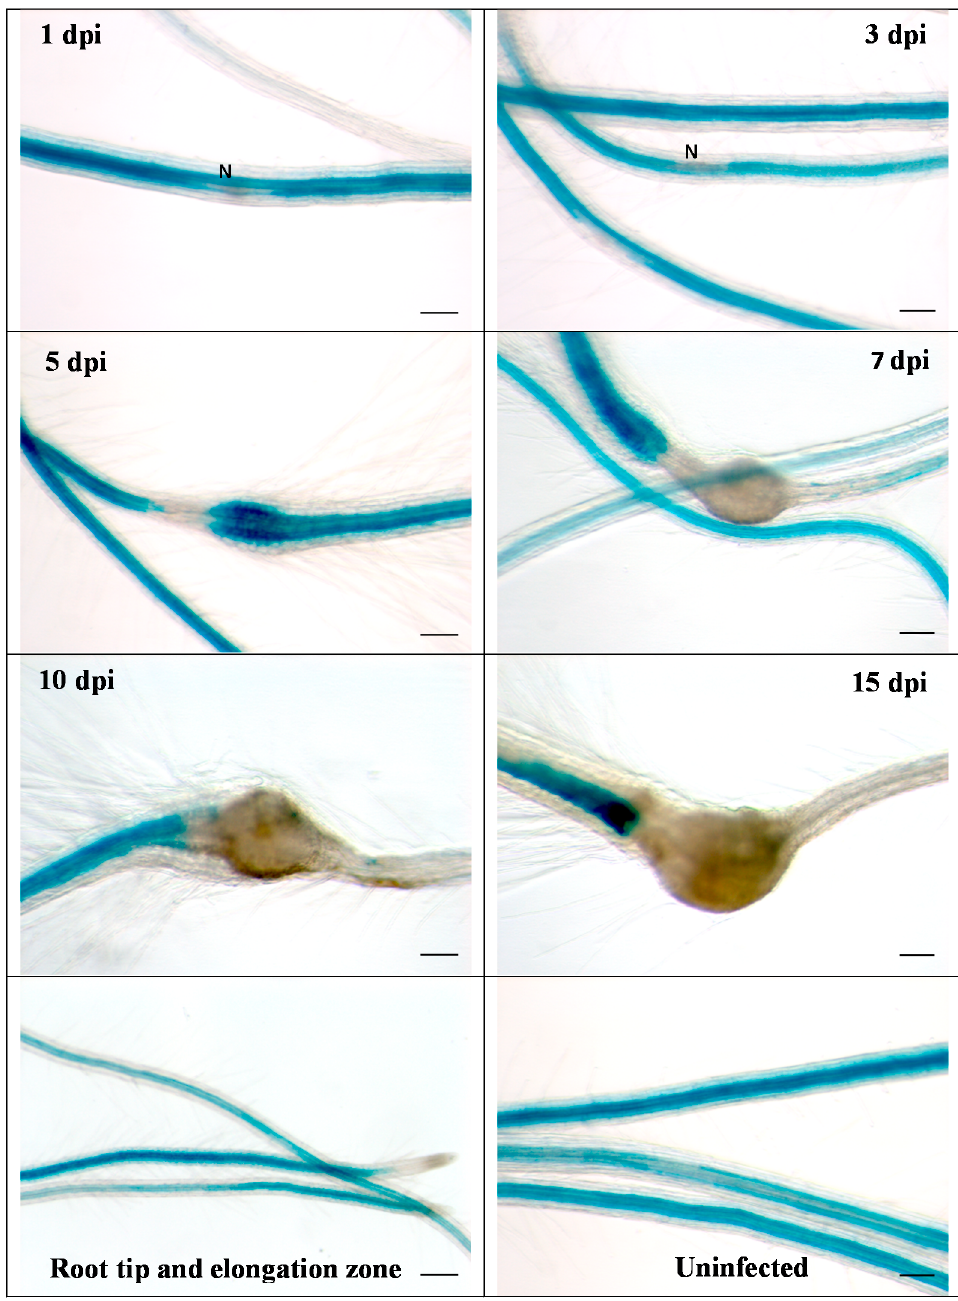
Figure 3. GUS expression in RbohB::GUS transgenic line infected with M. incognita . Shown are infection sites at 1, 3, 5, 7, 10 and 15 dpi of roots grown on Knop medium as well as uninfected roots and root tips with elongation zone. Downregulation of GUS expression at infection sites is clearly visible at 5 dpi. There was no GUS expression in galls at 7, 10 and 15 dpi. N, nematode. Bar = 100 μ m.